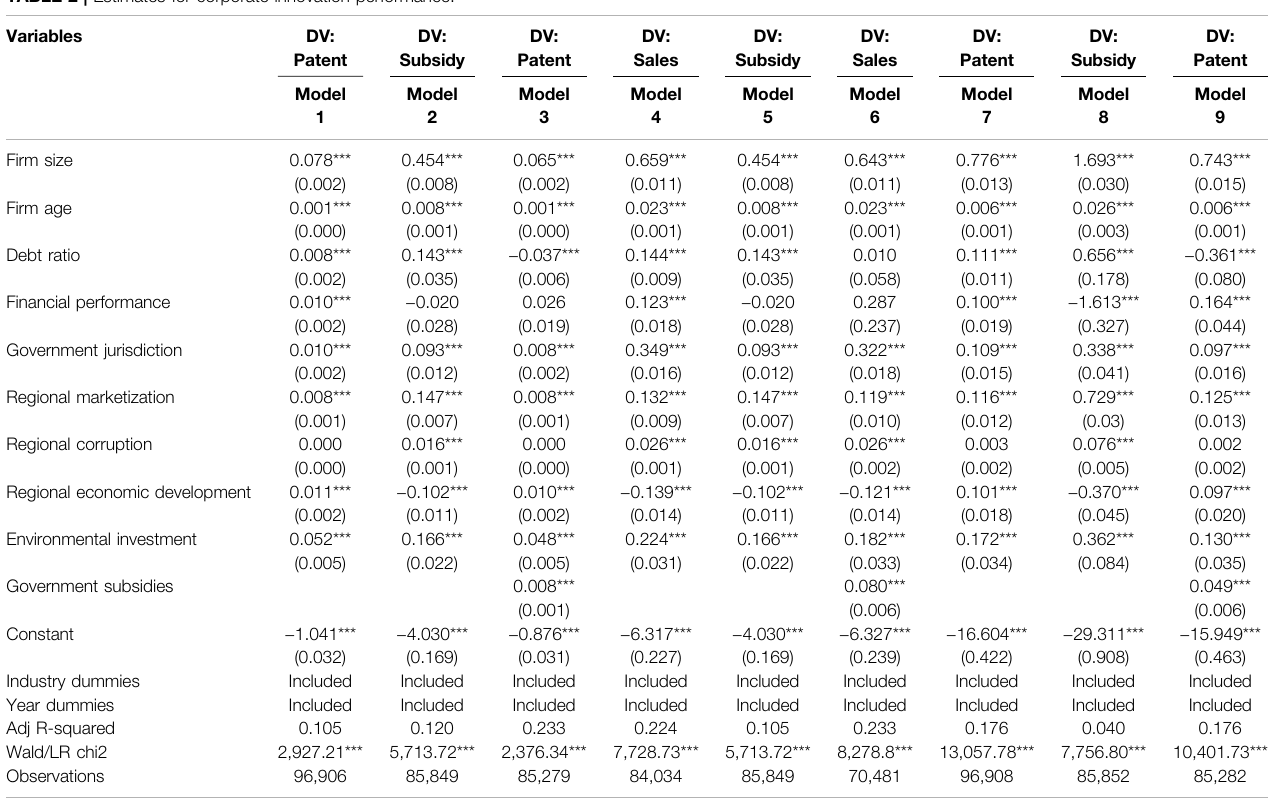
TABLE 2 | Estimates for corporate innovation